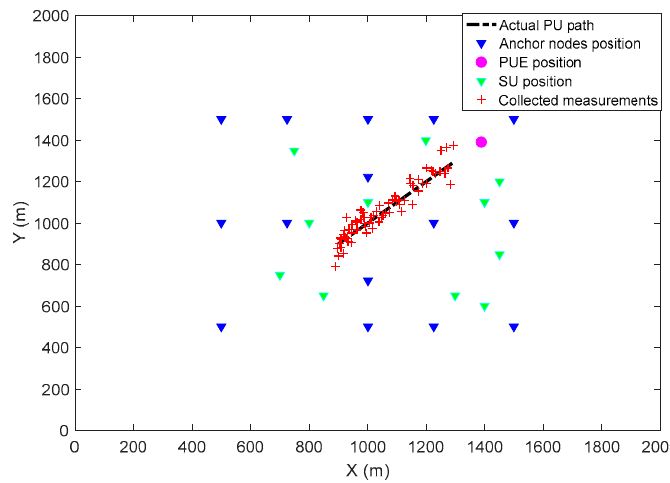
Figure 3. Simulation scenario of the mobile primary user the fixed primary user emulation attacker, secondary users and anchor nodes. The red symbols represent the collected measurements gathered by the anchor nodes.